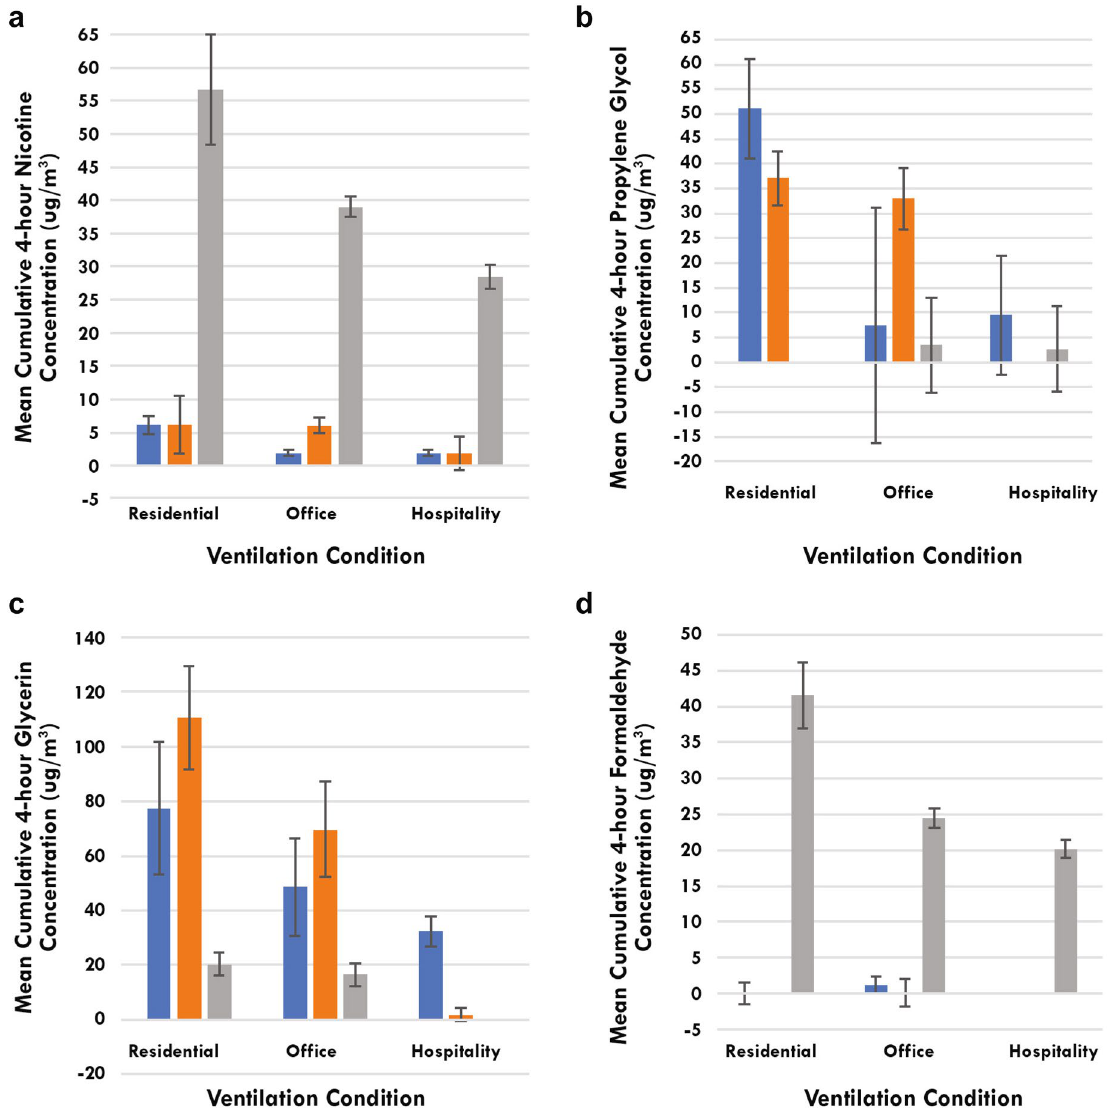
Figure 1. Comparison of mean cumulative (± SD) nicotine, propylene glycol, glycerin and formaldehyde concentrations measured after 4-h of ad libitum product use for all Groups. Group I—Blue bars, Group II— Orange bars, and Group III gray bars. Missing bars indicate that the cumulative mean concentrations were below baseline